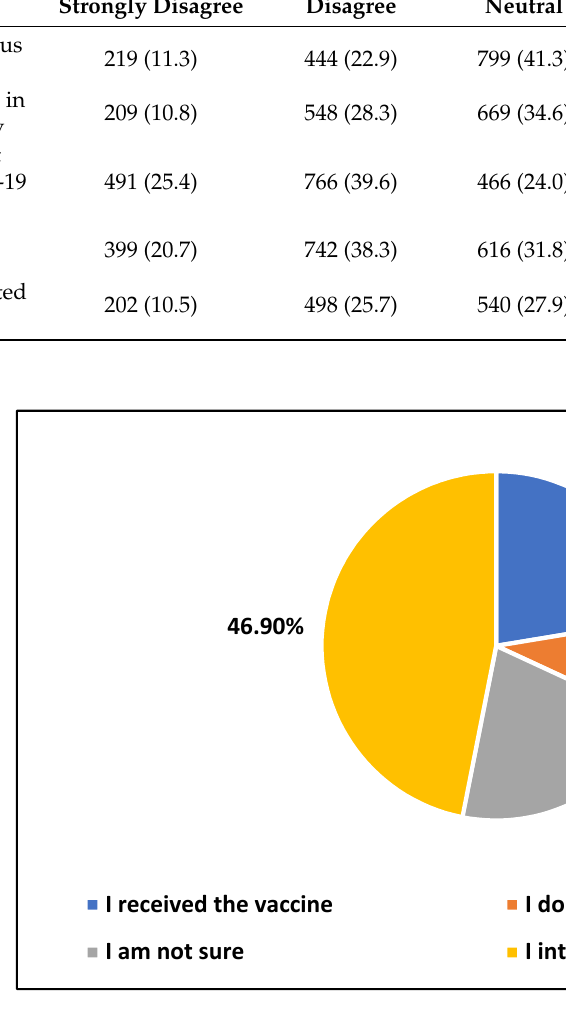
Figure 1. Vaccination status of participants.